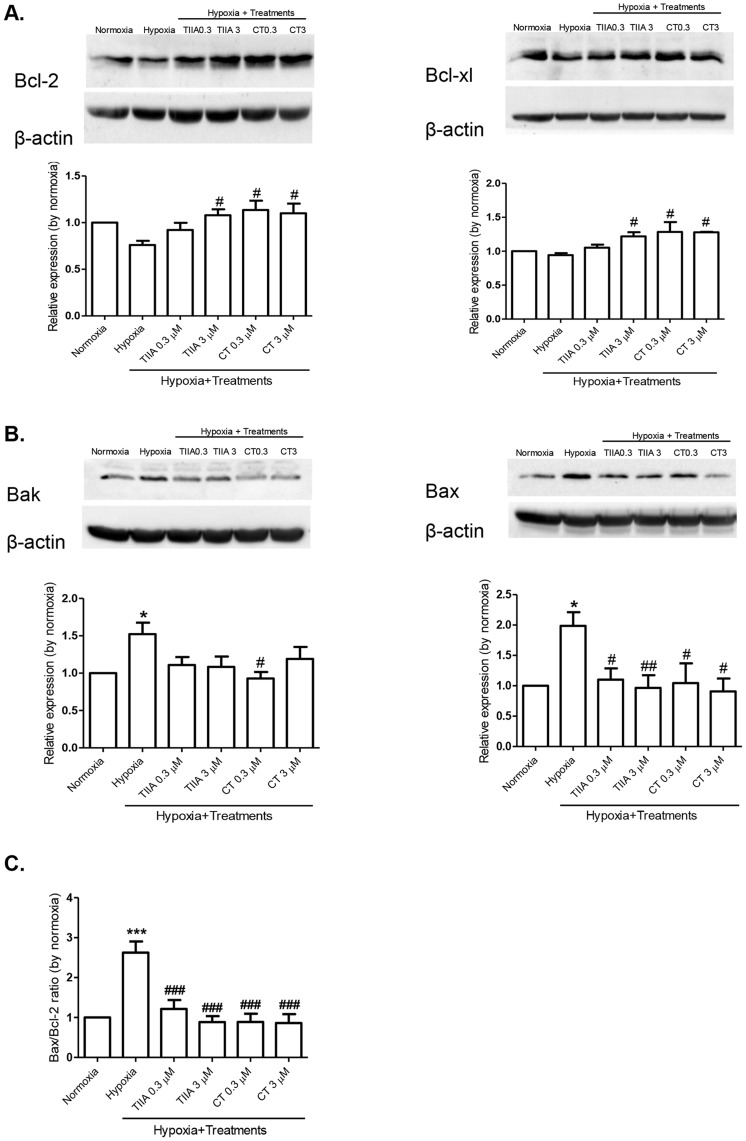
Effects of TIIA and CT on expressions of Bcl-2 family proteins on hypoxia induced H9c2 cells. (A) Anti-apoptotic proteins expression: Bcl-2 protein (50 µg) and Bcl-xl protein (20 µg) expression. (B) Pro-apoptotic proteins expression: Bak and Bax proteins expression (80 µg). (C) Bax/Bcl-2 ratio. Data shown are representative mean ± SEM of 4–5 independent experiments. * P<0.05 vs. normoxia, # P<0.05 vs. hypoxia, ## P<0.01 vs. hypoxia, *** P<0.001 vs. normoxia, ### P<0.001 vs. hypoxia.